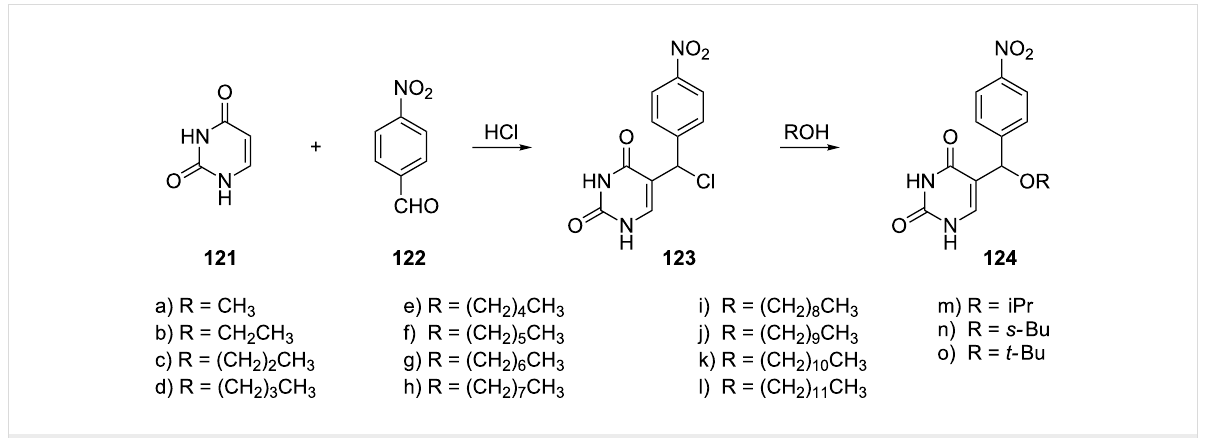
Scheme 21: Synthesis of 5-[alkoxy-(4-nitrophenyl)methyl]uracils 124